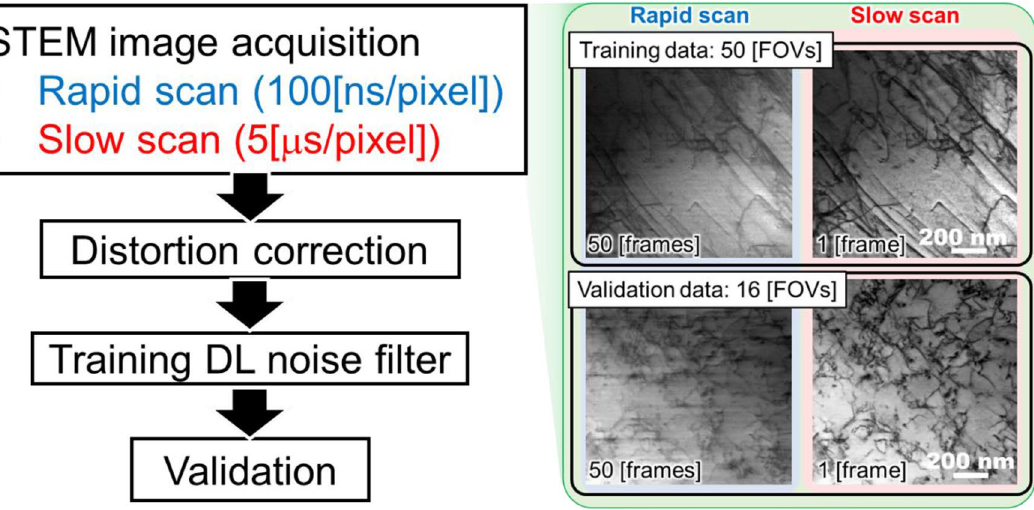
Figure 2. Flow chart of this study. Example images of a training dataset and a validation dataset are also